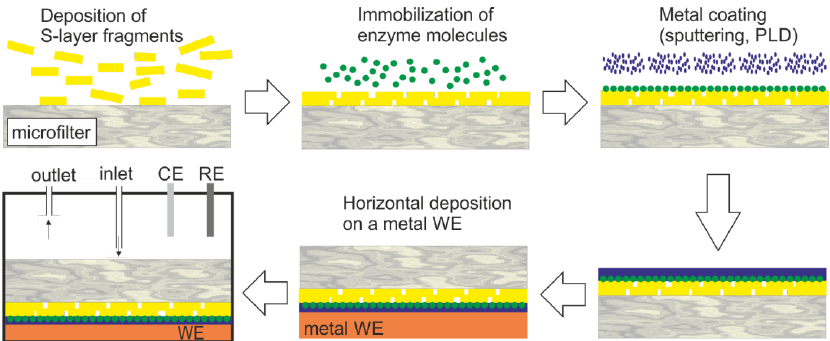
Figure 7. Generalized scheme of the construction of an S-layer ultrafiltration membrane (SUM)-based biosensor (not drawn to scale). S-layer carrying fragments or self-assembly products are deposited on a commercially available microfilter in a pressure-dependent process. The enzyme is deposited on the S-layer surface and chemically linked to the S-layer protein. The immobilized enzyme is contacted by a thin metal layer (PLD: pulse-laser-deposition). Finally, this composite structure is deposited with the metal layer side on the working electrode (WE) and mounted in a flow cell (RE: reference electrode, CE: counter electrode). The analyte is pumped in the flow cell. After passage across the modified SUM, the analyte reacts with the enzyme, which is detected by